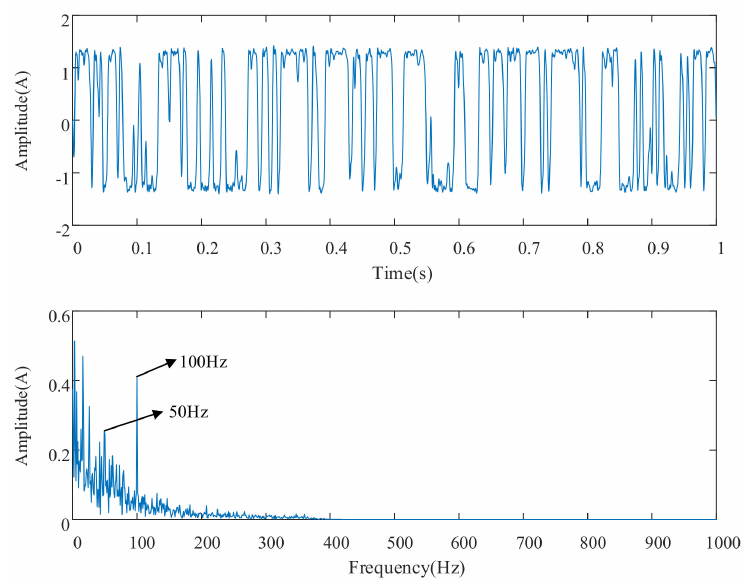
Figure 17. Wavelet packet decomposition of time − frequency domain reconstructed signal enhanced by second ACSRS.